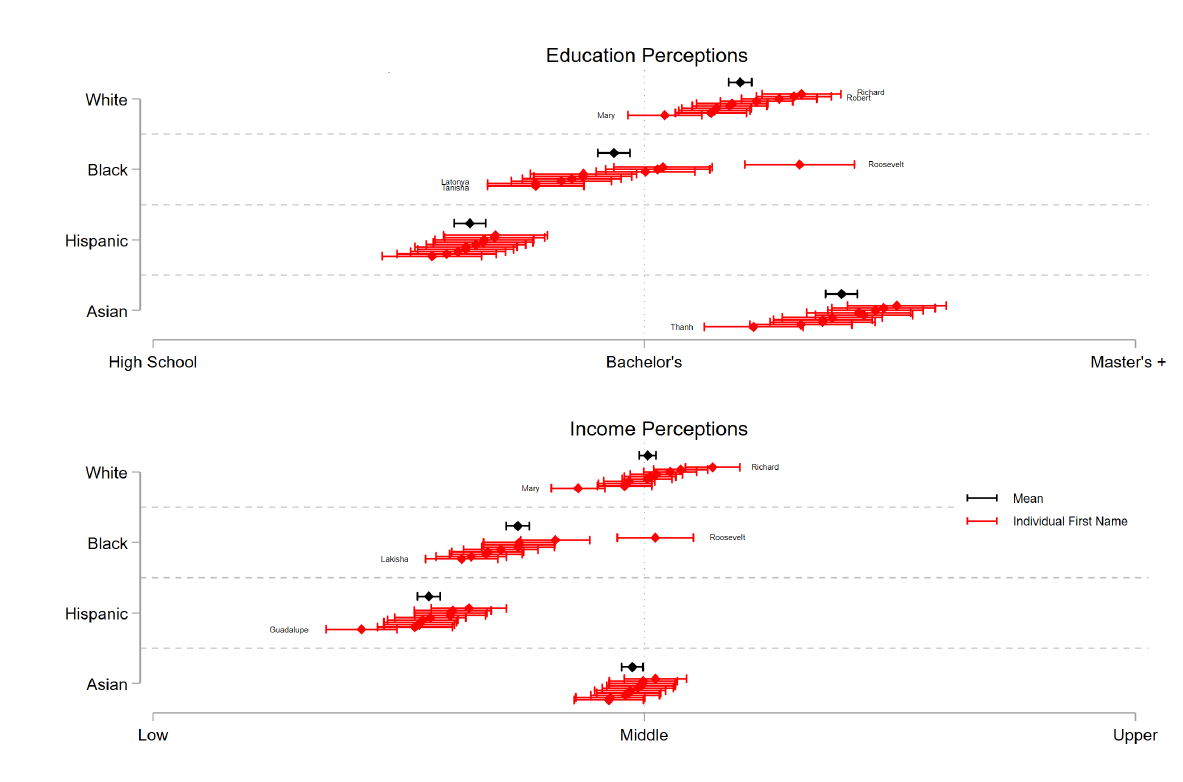
Figure 2: Heterogeneity in education and income perceptions by first names. Note: Pooled data from Studies 1 through 3 shown. This plot shows respondent perceptions of educational attainment and income based on names intended to signal different racial/ethnic categories. Plotted points denote predictions and bars represent 95 percent confidence intervals.